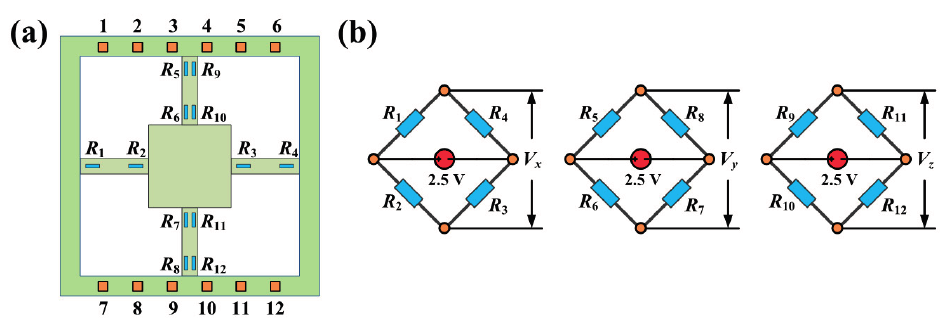
Figure 4. Stress detection circuit. ( a ) Resistors distribution; ( b ) Wheatstone